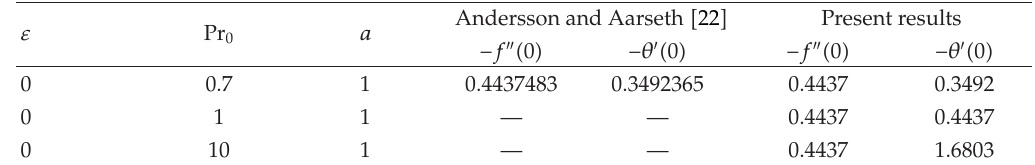
Table 1: Values of the reduced skin friction coe ffi cient f (cid:4)(cid:4) (cid:5) 0 (cid:6) and reduced heat flux θ (cid:4) (cid:5) 0 (cid:6) at the moving surface for Pr 0 (cid:8) 0 . 7 , 1, and 10 when a (cid:8) 1 in Case A: constant fluid properties.